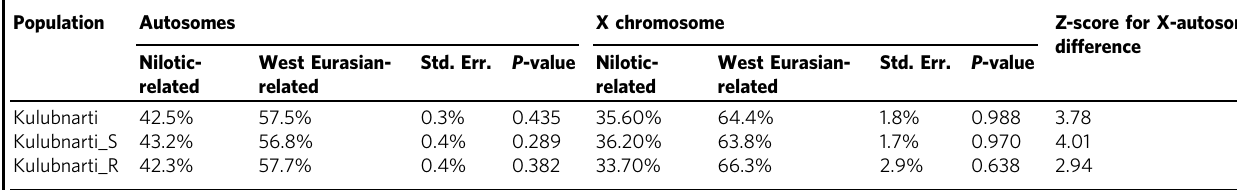
Table 2 qpAdm models for sex-biased admixture estimated using the autosomes and the X chromosome. Population X chromosome Z-score for X-autosome